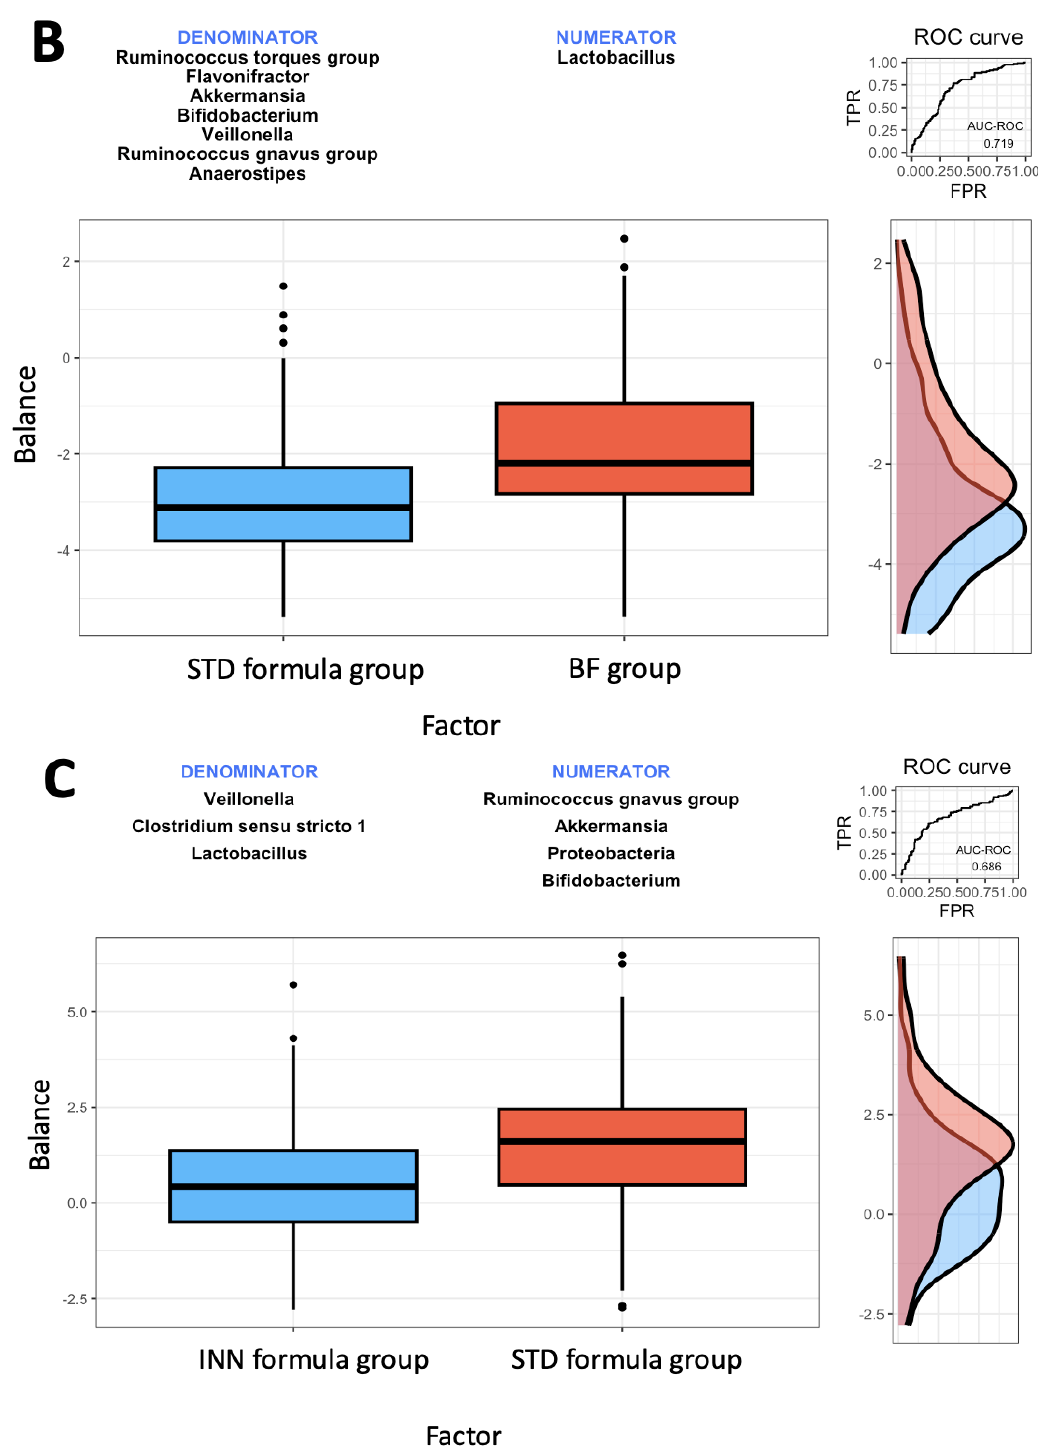
Figure 1. Description of the global balance for groups. The two groups of taxa that form the global balance are specified at the top of the plot. The box plot represents the distribution of the balance scores for INN and BF group ( A ), STD and BF groups ( B ), and INN and STD groups ( C ). The right part of the figure contains the ROC curve with its AUC (mean area under the ROC curve) value and the density curve for each group.